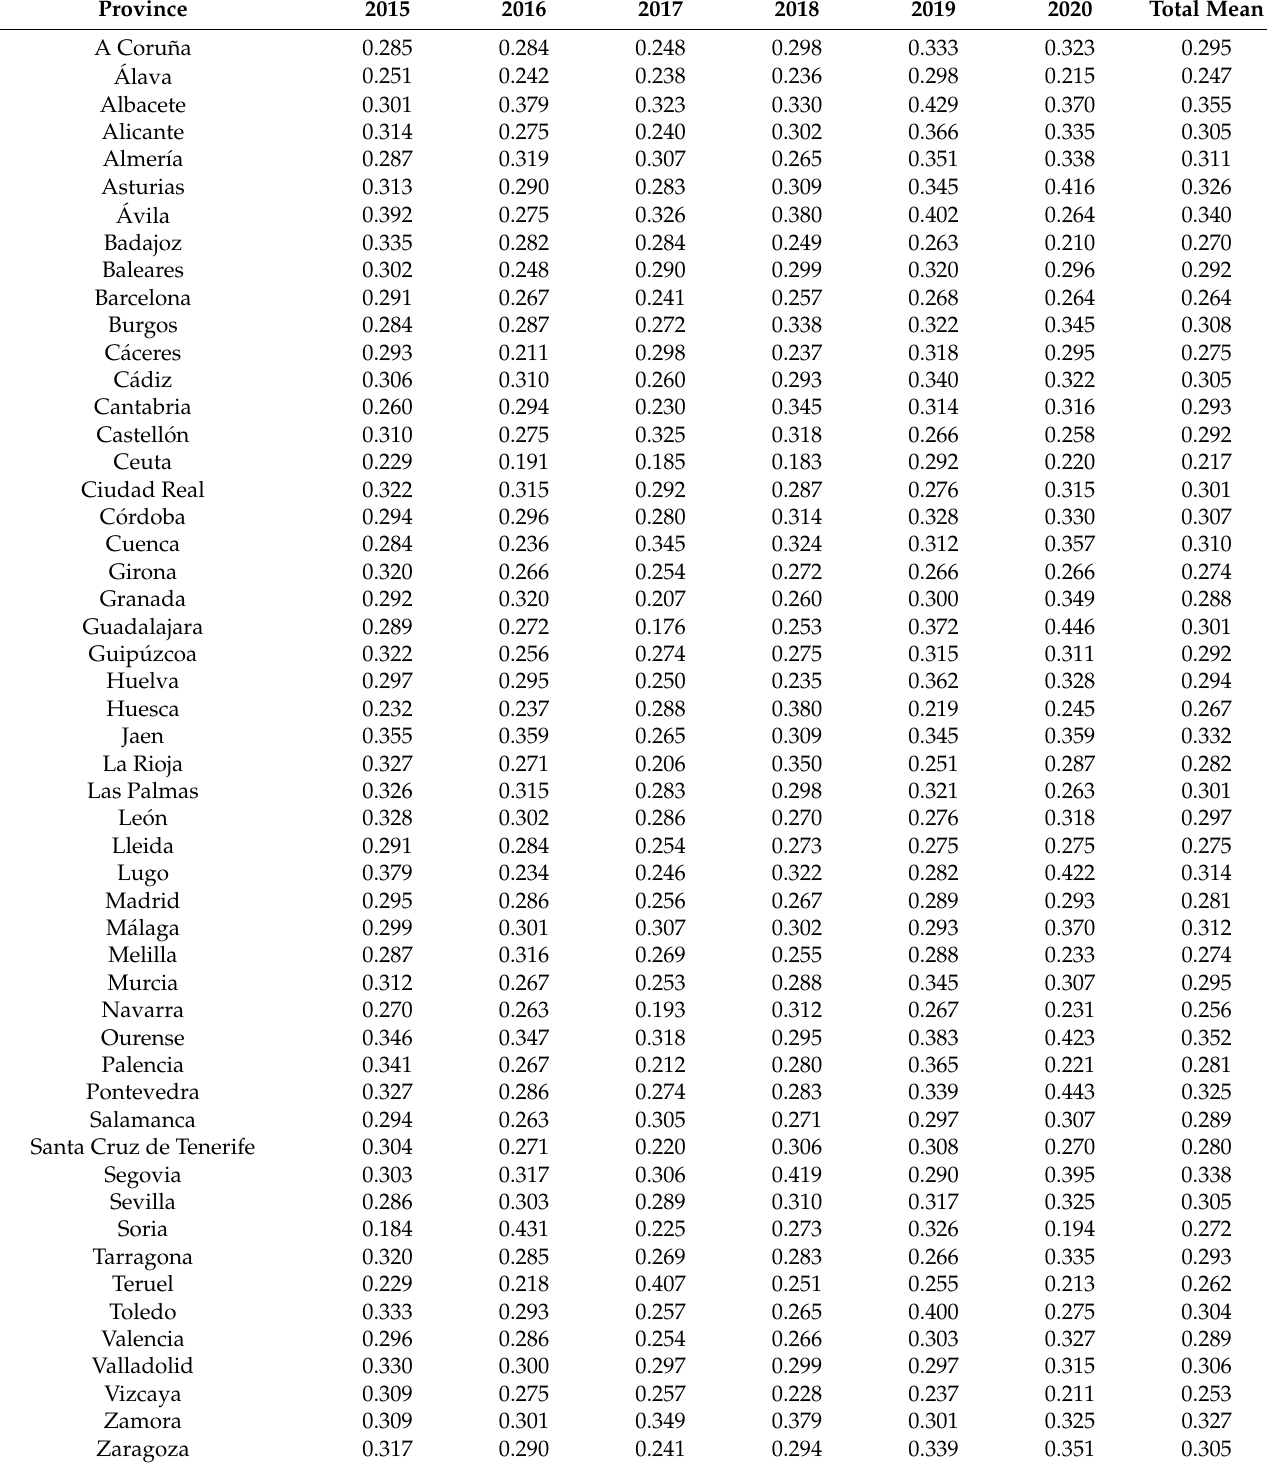
Table A3. Hate speech average present on Twitter in Spain 1 by provinces (NUTS